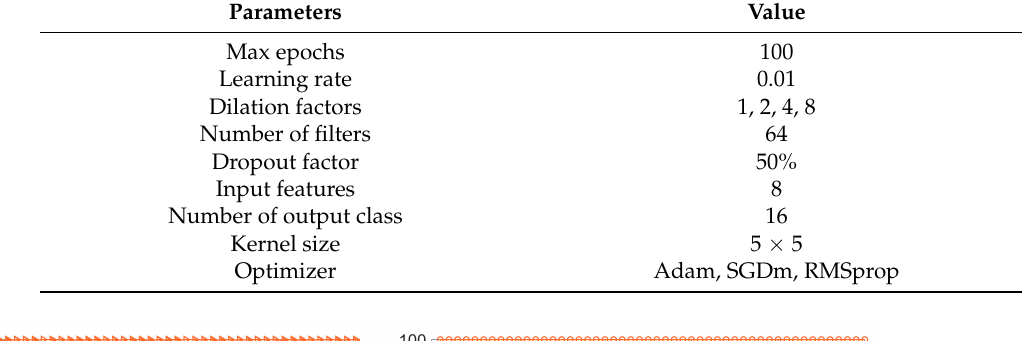
Table 2. Model training parameters.